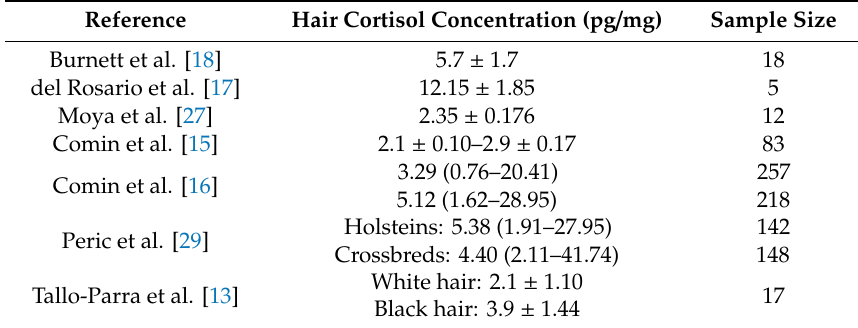
Table 8. Comparative results of studies on the analysis of hair cortisol concentration in